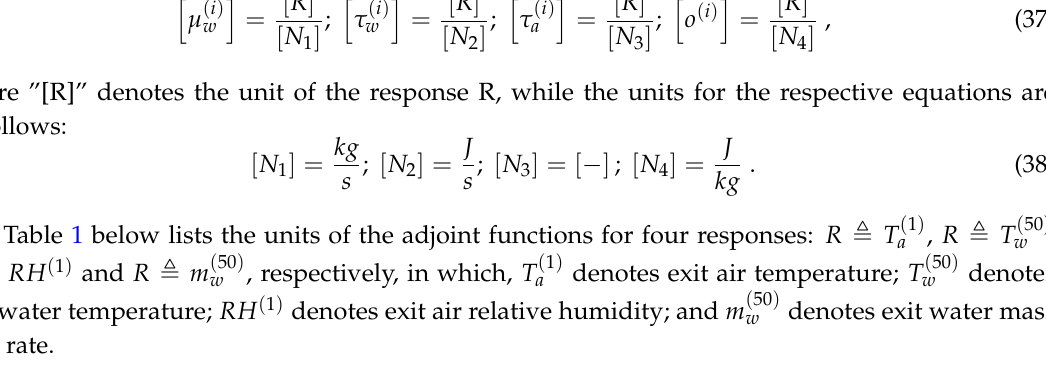
( 50 ) w , respectively, in which, T